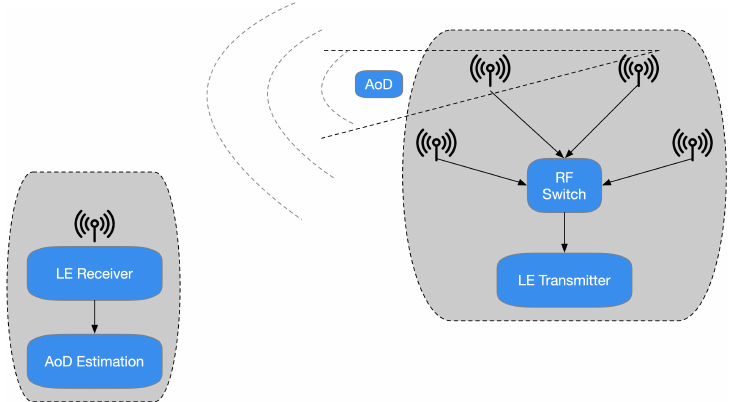
Figure 6. In an IPS system of AoD radiogoniometry, set beacons practice arrays of the antenna to transmit BLE 5.1 data with CTE. The foremost calculations take place in the mobile device, for instance, in a consumer’s